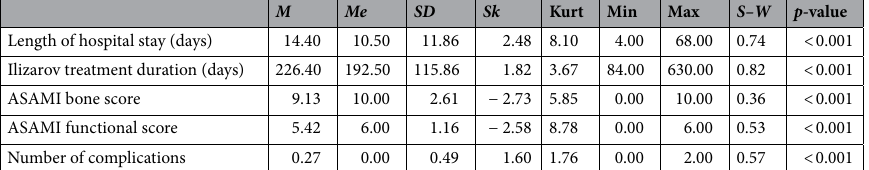
Table 2. Descriptive statistics and Shapiro–Wilk test results for quantitative variables in the patients who underwent closed fixation procedures (n = 48). M mean, Me median, SD standard deviation, Sk. skewness, Kurt. kurtosis, Min minimum, Max maximum, S–W Shapiro–Wilk test result, p-value significance of normality of distribution.